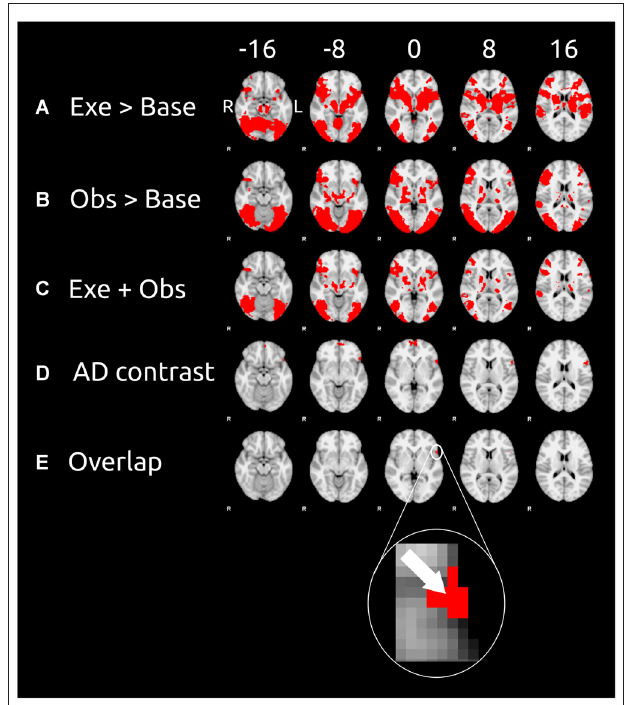
FIGURE 2 | Cortical clusters exhibiting significant activation as revealed by the contrasts (left) of the unimodal session and cross-modal session. These contrasts were calculated on the data of the 10 participants. Six equidistant transverse slices (exact coordinates are shown at the top) were taken for each contrast of our analysis (contrast labels are in the leftmost column). (A) The results of the contrast execution > baseline (unimodal session; results of step 1); (B) the results of the contrast observation > baseline (unimodal session; results of step 1); (C) cortical areas that survived both of the previous contrasts; (D) the results of the cross-modal adaptation contrast (cross-modal session; results of step 2) AD is the adaptation difference (AD) as defined in Equation (1); (E) cortical areas that survived all three previous contrasts (results of step 3). For sake of clarity the arrow in inset shows the voxel with the peak activity (as measured by the AD contrast) in the overlap cluster. Data are displayed in the radiological convention: left hemisphere on the right of each